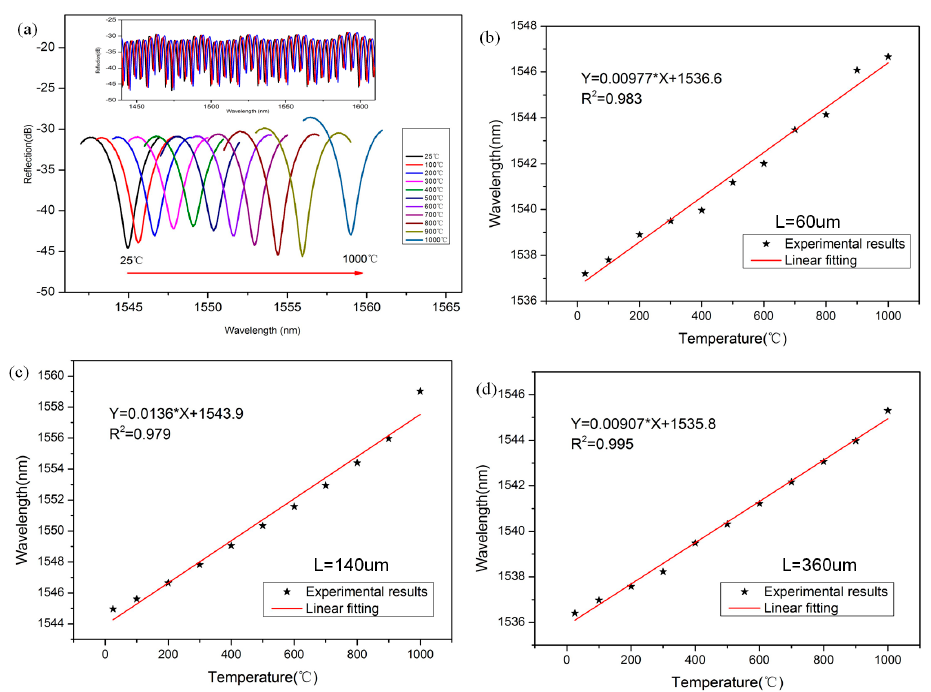
Figure5. ( a ) Shift of reflection spectrum with temperature ( L = 140 μ m); the wavelength-temperature Figure 5. ( a ) Shift of reflection spectrum with temperature ( L = 140 µ m); the wavelength-temperature relationship and their linear fitting ( b ) L = 60 μ m; ( c ) L = 140 μ m and ( d ) L = 360 μ m. relationship and their linear fitting ( b ) L = 60 µ m; ( c ) L = 140 µ m and ( d ) L = 360 µ